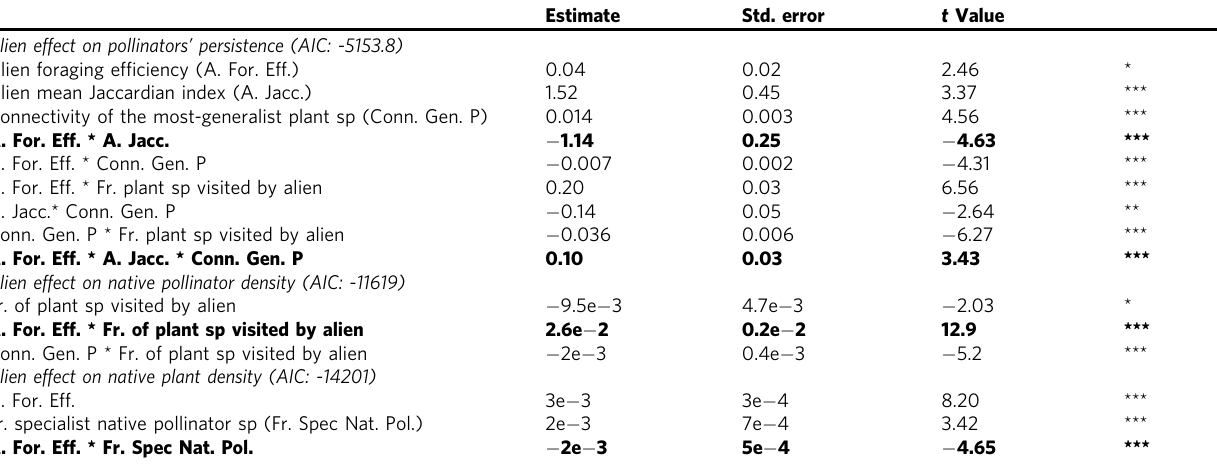
Predictorsof themodelswerechosenbasedonCARTresultsandthebestmodelswerechosenusingAIC.Evaluatedpredictorsforthealieneffectsonnativepollinators ’ persistenceanddensitywere(1) alienforagingef fi ciency,(2)alienmeanJaccardianindex,(3)connectivityofthe